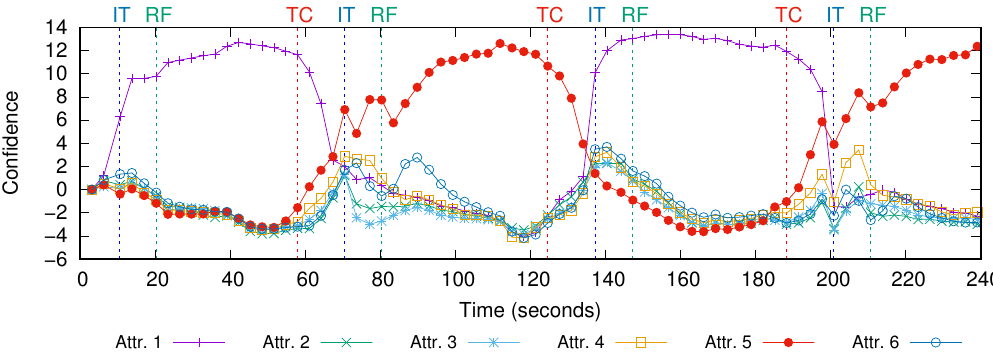
Figure 8. The traffic rate on the links from core node 6 to core node 9 and core node 1 to core node 9.